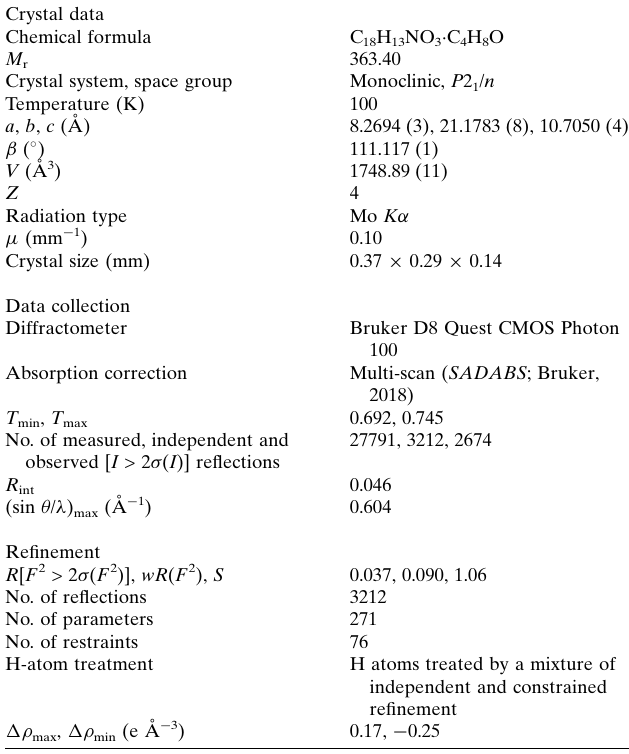
Crystal data Chemical